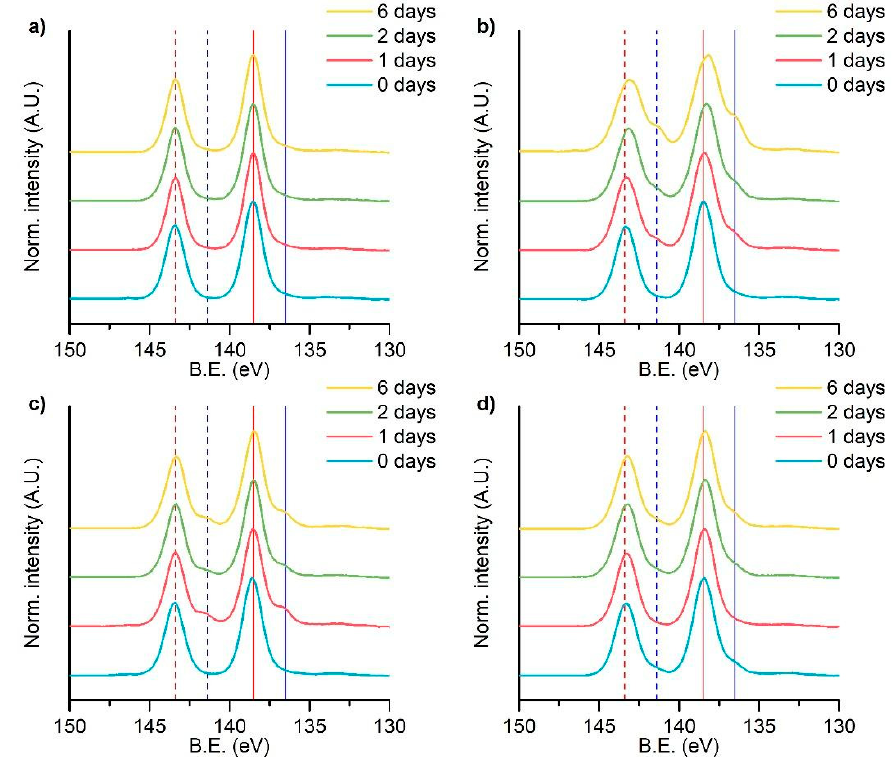
Figure 6. X-ray photoelectron spectroscopy (XPS) characteristic peaks of lead: ( a ) silica glass, ( b ) ITO, ( c ) soda-lime glass and ( d ) gold. Solid lines = main peaks; dashed lines = secondary peaks.